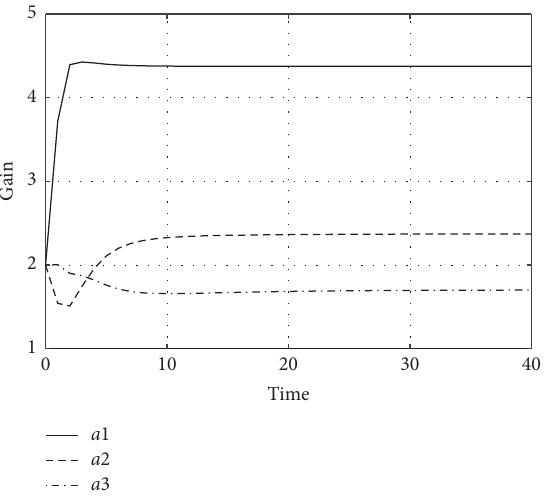
Figure 3: Gain trajectory of system without communication delay.